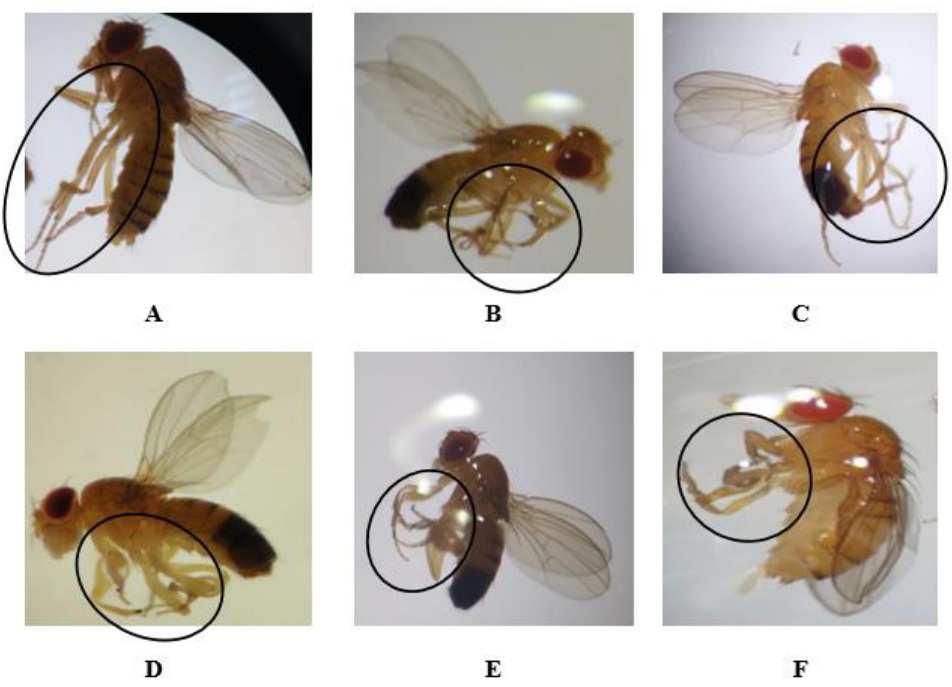
Figure 4. Normal ( A ) and abnormal leg phenotypes ( B – F ) in the F0, F1, F2, and F3 generations obtained after treatment with permethrin (0.1 mM), permethrin nanopesticides (2.5 mM), acephate and acephate nanopesticides (5 mM), and validamycin and validamycin nanopesticides (2.5 mM) for Drosophila larvae. Black circles indicate the defective area in the image. Each application concentration was performed in three replicates for each generation.